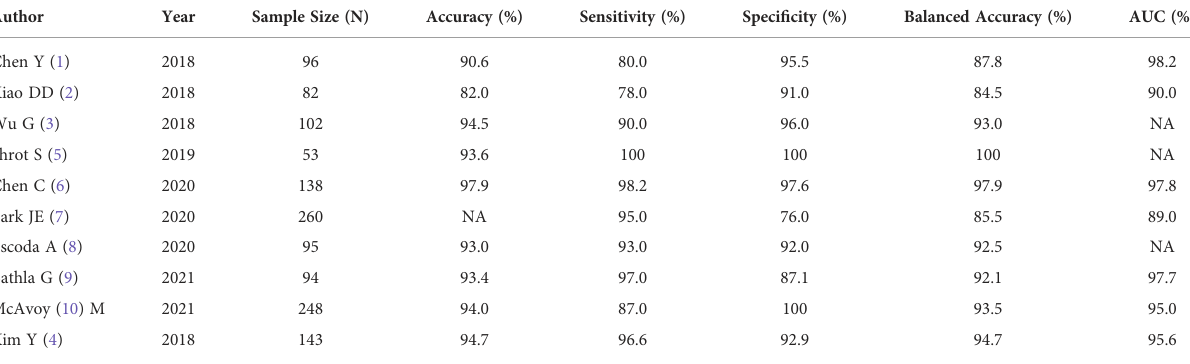
TABLE 3 Summary of the diagnostic metrics of all the studies included in the meta-analysis.